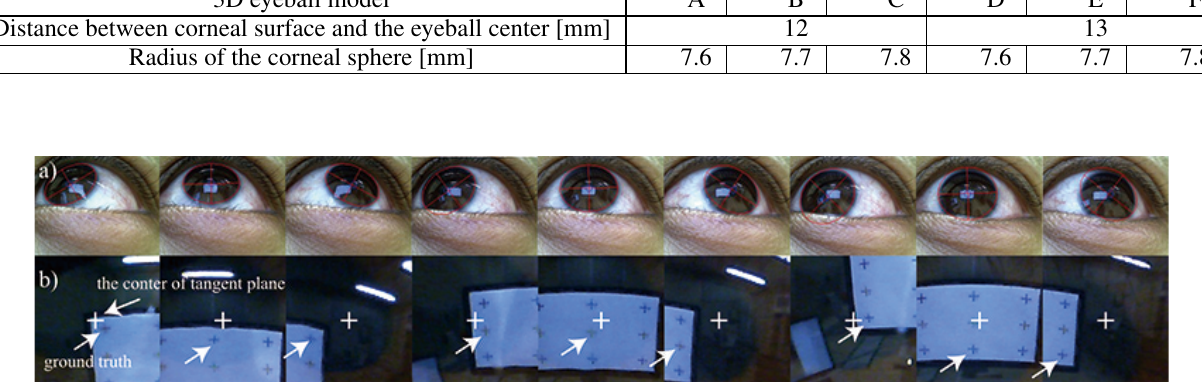
Figure 17 . Results of model-based tracking and the unwarped images obtained. The upper figures are the results obtained when tracking the iris areas, where the estimated iris areas are indicated in red. The lower figures are the unwarped images, which were generated around the center of the iris, where the white crosses and arrows are the center of the unwarped image and the focused marker, respectively.